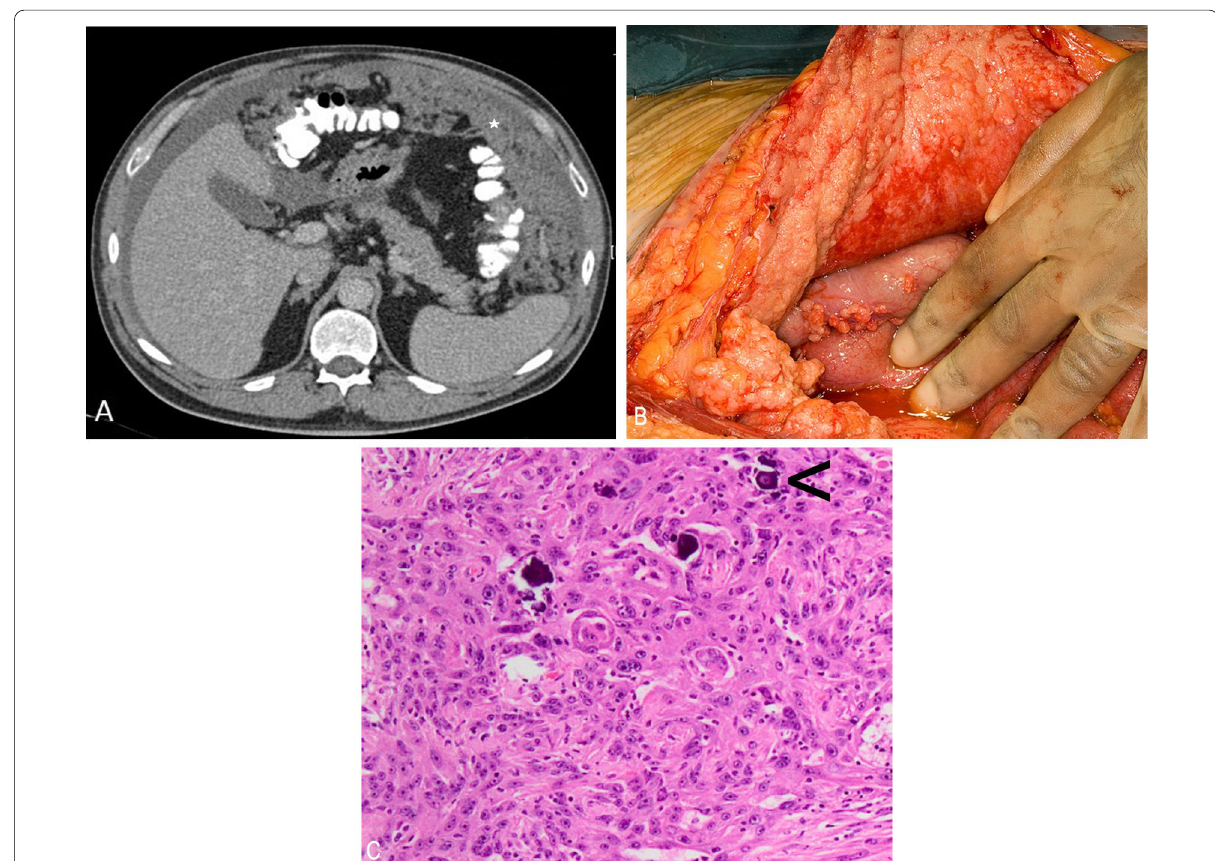
Fig. 6 a – c 56-year-old male with ‘wet’ appearance of epithelioid peritoneal mesothelioma. a CT axial images showing omental cake (*) and ascites b Intraoperative photograph showing omental cake, peritoneal thickening and ascites. c High-power photomicrograph (H&E, pleomorphic sheets of epithelioid cells with large nuclei, prominent nucleoli and eosinophilic cytoplasm. A few psammoma bodies are visible; one is marked with an